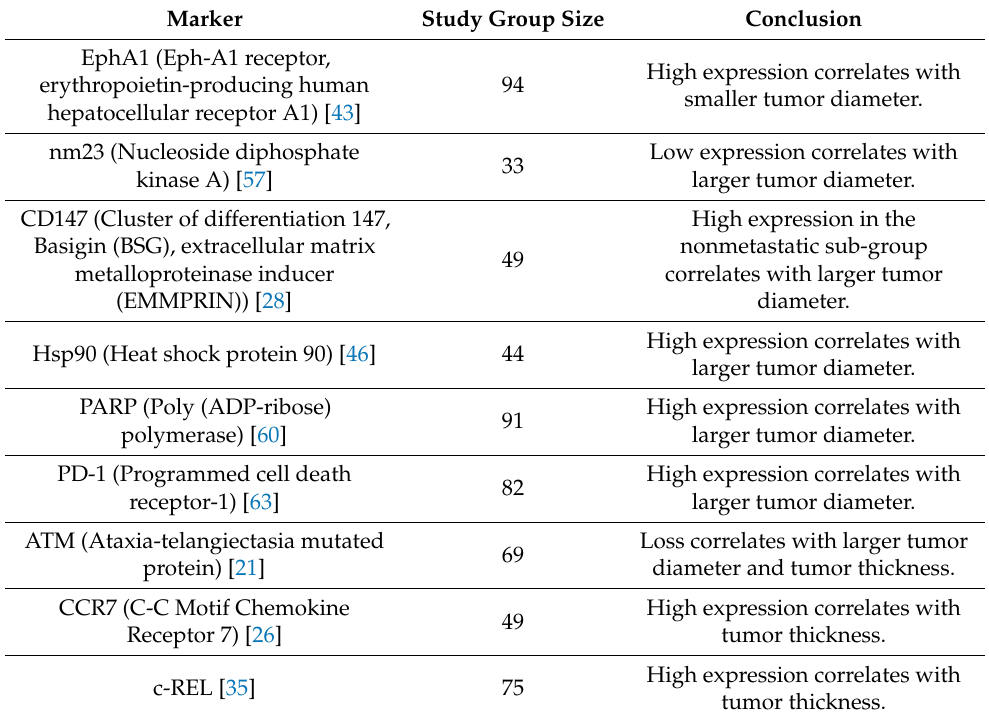
Table 2. Summary of markers whose expression is related to tumor